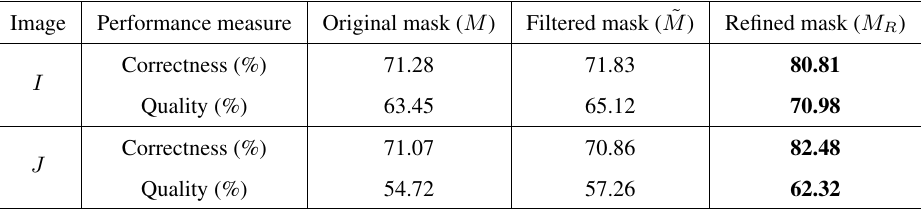
Table 2: Correctness and Quality measures of the original, filtered, and refined masks in detecting the boundaries of the buildings in images I and J .